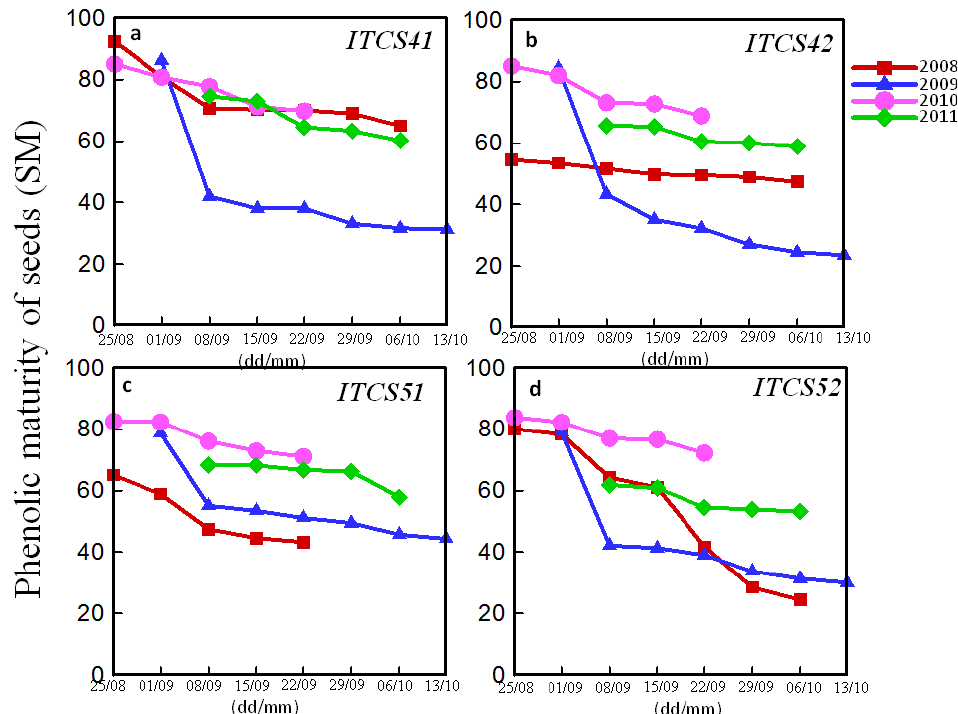
Figure 3. Seeds phenolic maturity of four plots ITCS41 ( a ); ITCS42 ( b ); ITCS51 ( c ); and ITCS52 ( d ) of Cabernet Sauvignon grapes as a function of time (day (dd)/month (mm)) over four years (2008, 2009, 2010, and 2011).